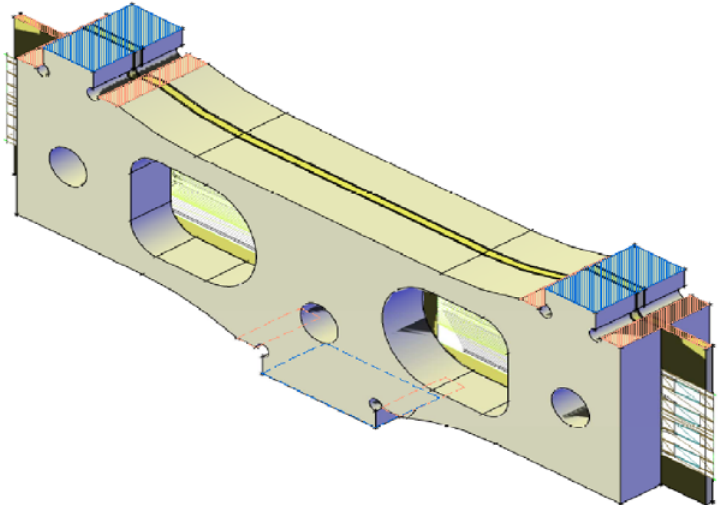
Figure 12. Final version of the WIM sensor module.